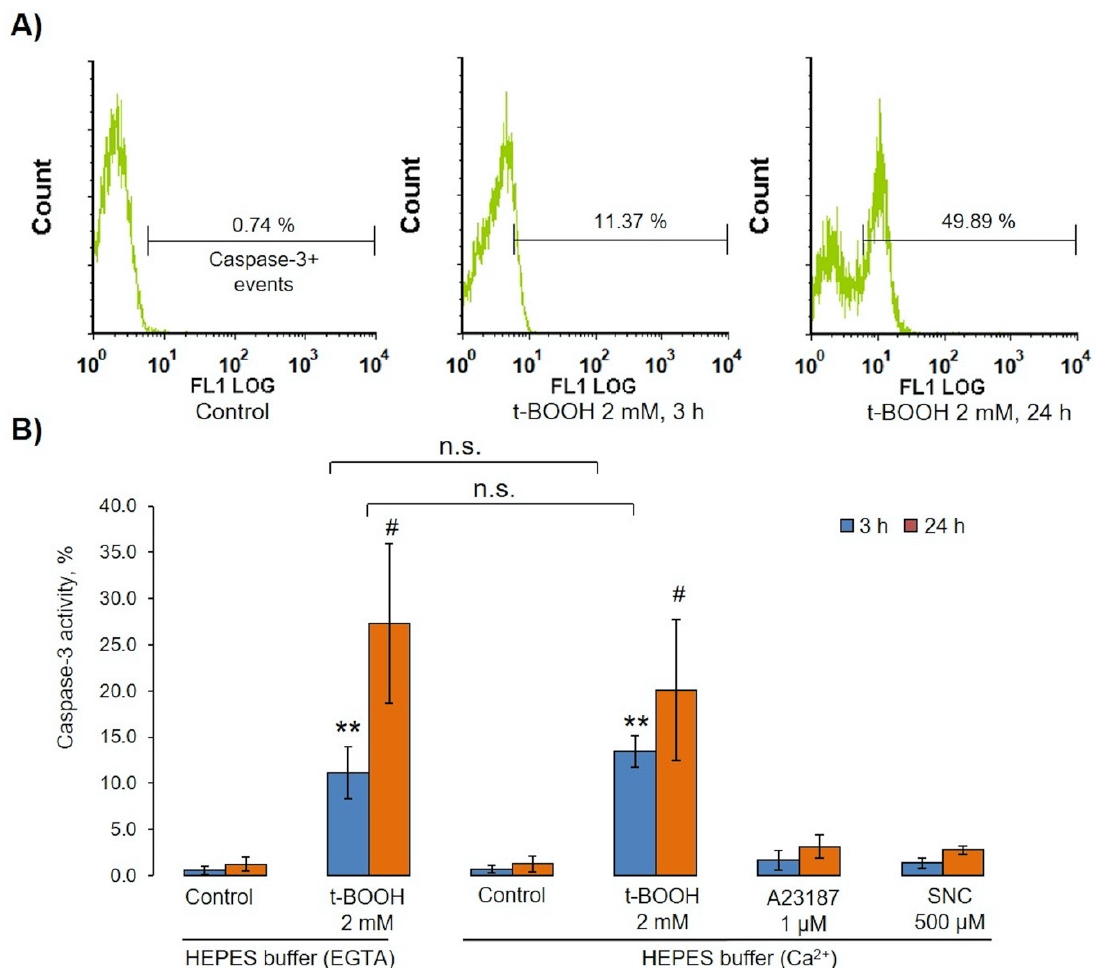
Figure 9. t-BOOH-induced OS activated caspase 3 in RBCs. RBCs (0.5 × 10 9 cells/mL) were incubated with indicated concentrations of t-BOOH, A23187, and SNC in HEPES buffer containing 2 mM calcium or 2 mM EGTA for indicated times. After we incubated them with indicated compounds, cells were fixed by 1% (final concentration) of methanol-free formaldehyde, permeabilized by 0.5% Tween for 20 min, and then anti-active caspase-3 antibodies were added for 30 min, with caspase-3 activation being measured by flow cytometry according to the manufacturer’s instructions. ( A ) Original histograms from one of seven independent experiments. ( B ) Data quantification based on seven independent experiments. Data are presented as the mean ± SD ( n = 7), one-way ANOVA (HEPES buffer with EGTA both 3 h and 24 h), Tukey HSD post hoc (HEPES buffer with Ca 2+ 3 h), Tamhane T2 post hoc (HEPES buffer with Ca 2+ 24 h); paired t-test HEPES buffer (EGTA) and HEPES buffer (Ca 2+ ), ** p < 0.001 compared to corresponding control, # p < 0.05 compared to corresponding control, n.s.— not significant.